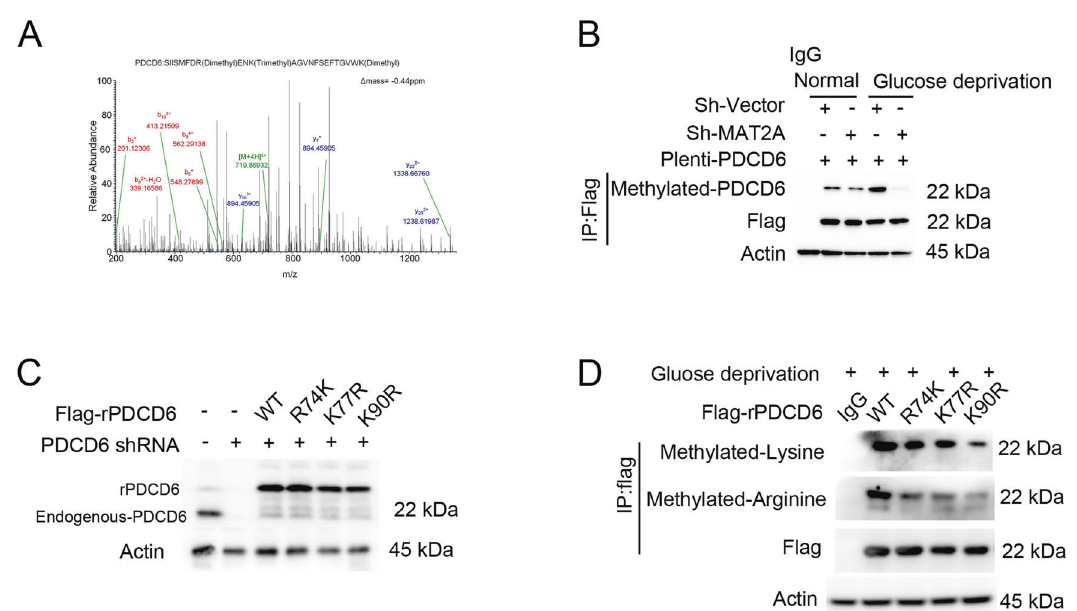
Fig. 3 PDCD6 is methylation at lysine 90 and increases the protein stability. A MS751 cells with expressing 3× fl ag-MAT2A were cultured for 12 h under glucose deprivation. Immunoprecipitation was performed using Flag antibody, and the extracts were analyzed by mass spectrometry. The results of a mass spectrometric analysis revealed that 3 amino acids, R74, K77 and K90, of PDCD6 were methylated. B MS751 cells transfected with shMAT2A or 3× fl ag-PDCD6 were cultured for 12 h under normal or glucose deprivation. Cellular extracts were subjected to immunoprecipitation with an anti-methylated PDCD6 antibody. C MS751 cells were transfected a vector for control shRNA or PDCD6 shRNA and reconstituted with expression of WT rPDCD6, rPDCD6 R74K, rPDCD6 K77R or rPDCD6 K90R. Cell lysates were directly subjected to immunoblotting with the indicated antibodies. D MS751 cells were transfected with a vector for control shRNA or PDCD6 shRNA and reconstituted with expression of WT rPDCD6, rPDCD6 R74K, rPDCD6 K77R or rPDCD6 K90R. Cellular extracts were subjected to immunoprecipitation with an anti-arginine or lysine methylation